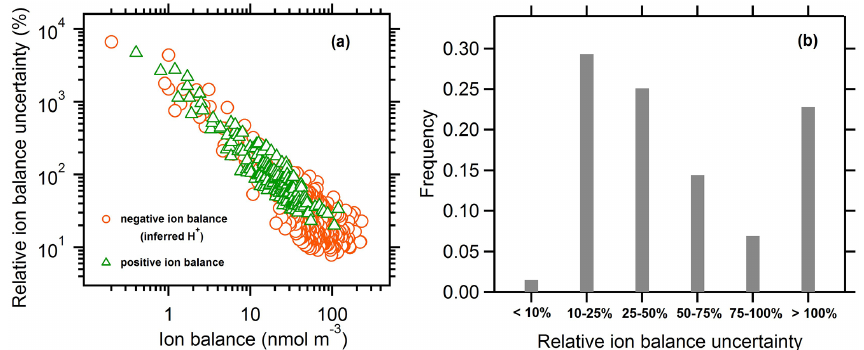
Figure 8. (a) Relative ion balance uncertainty (%) as a function of the ion balance level. Note that the orange trace represents [H + ], and so this trace also represents the uncertainty in [H + ] from the ion balance. (b) Frequency distribution in the relative ion balance